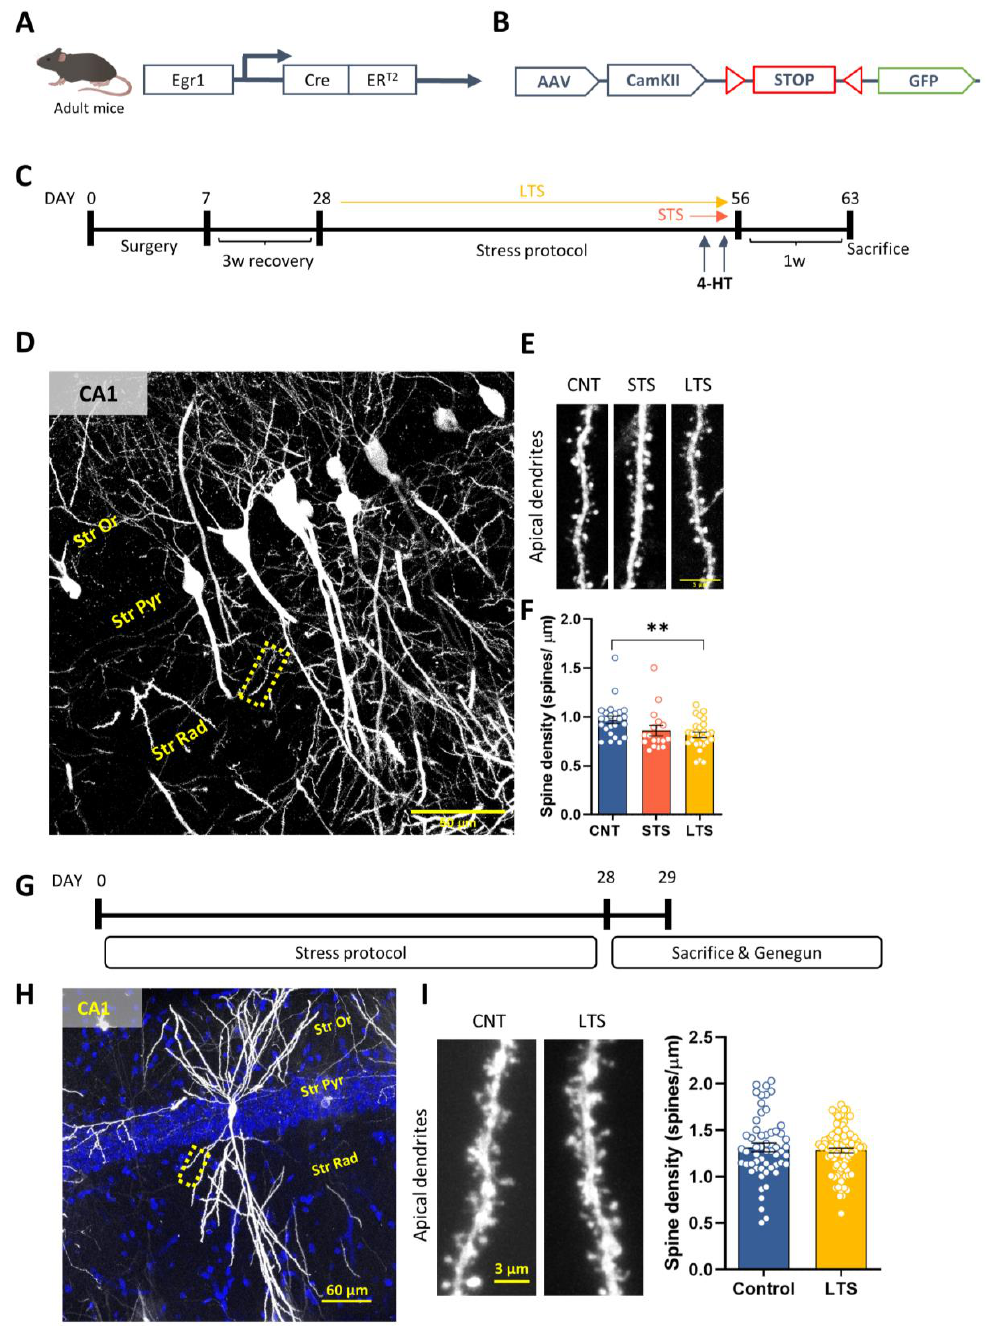
Figure 2. CUMS specifically alters dendritic spine density in Egr1-activated pyramidal neurons. ( A ), Schematic representation of the Egr1-CreERT2 mouse model and ( B ) AAV expressing GFP under the control of a STOP floxed codon. ( C ), Timeline of the experiment: Adult mice were injected with AAV-CaMKII-Flex-GFP. After recovery, they were exposed to 0 (CNT) or 2 (STS, orange arrow) or 28 days of CUMS (LTS, yellow arrow). On the last two days of CUMS, all animals received 50 mg/kg of 4-HT (i.p.) 30 min before the stressor. One week after the last stressor, animals were sacrificed